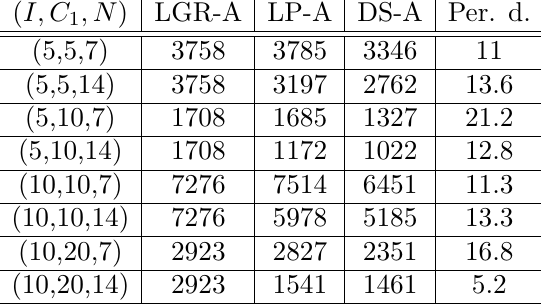
Table 3. Results for λ = 0 .